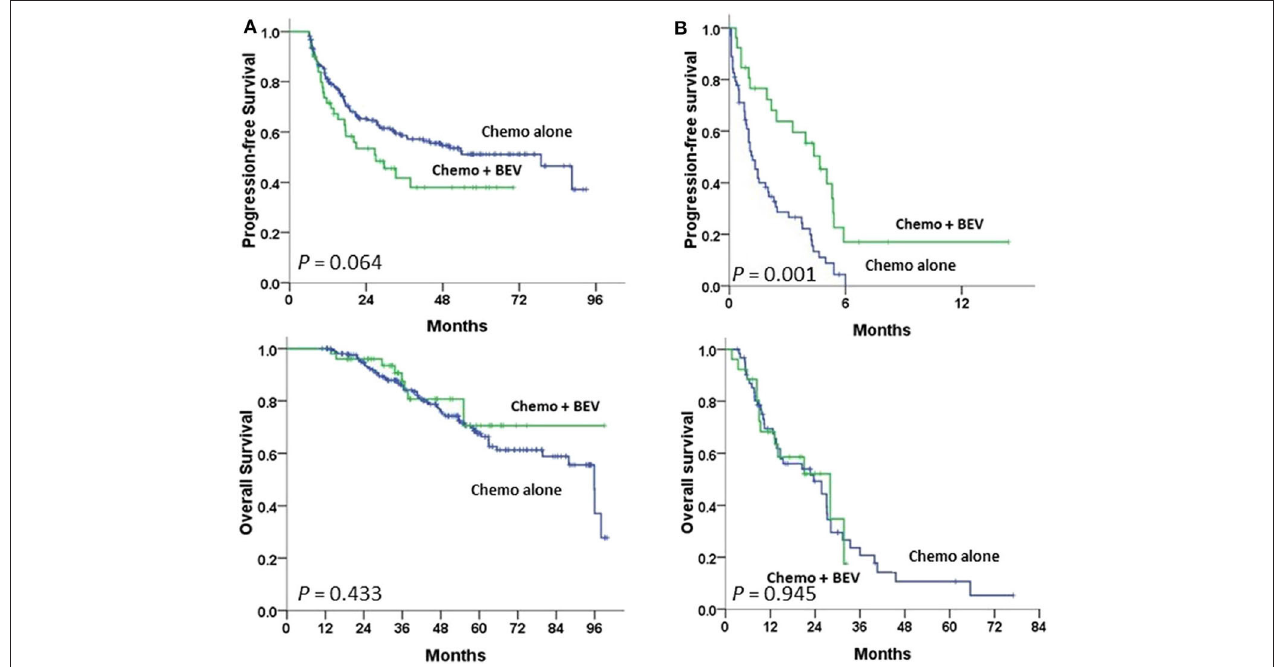
FIGURE 3 | Progression-free and overall survival between paclitaxel-carboplatin chemotherapy (Chemo) with and without bevacizumab (BEV) in stage III–IV patients undergoing first-line therapy were tested using the log-rank test (A) in the progression-free interval (PFI) ≥ 6m subgroup and (B) in the PFI < 6m subgroup.